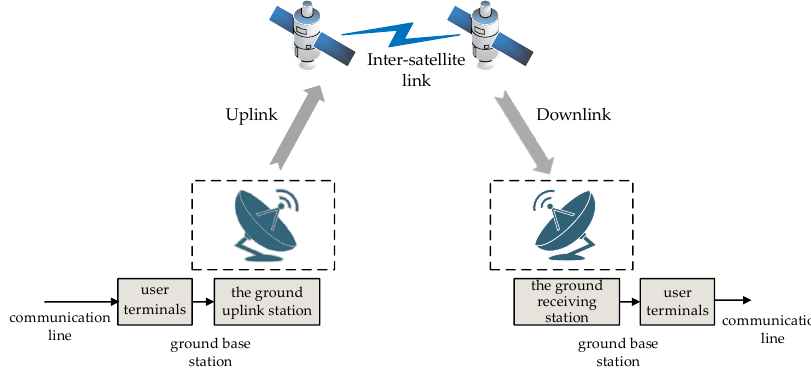
Figure 3. The composition of the satellite communication system.